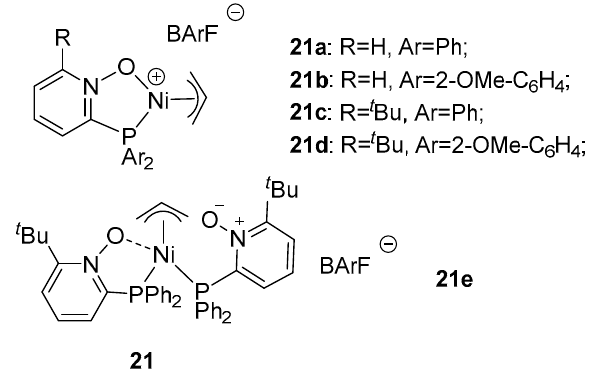
Figure 18. Cationic 2-phosphine-pyridine- N -oxide nickel catalysts 21a – e .